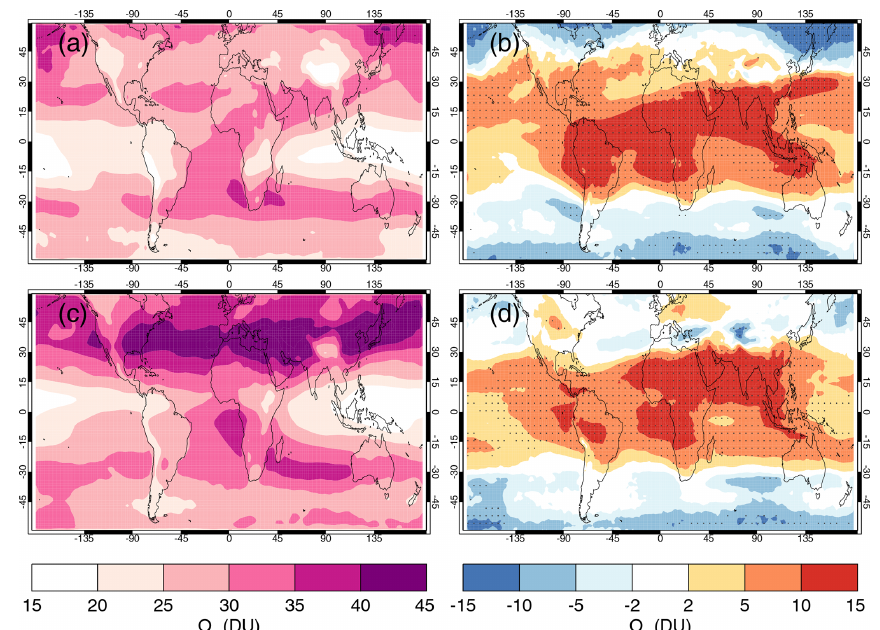
Figure 14. Comparison of observed and modelled tropospheric ozone columns (DU) from the ND simulations. Plots show seasonal means and differences for the period 2005–2014. (a) OMI-MLS tropospheric column (DJF); (b) difference between the model nudged simulations and OMI-MLS tropospheric column (DJF); (c) OMI-MLS (JJA) tropospheric column; (d) difference between the model and OMI-MLS tropospheric column (JJA). Stippling indicates grid points for which | bias | > 2 × SD of the